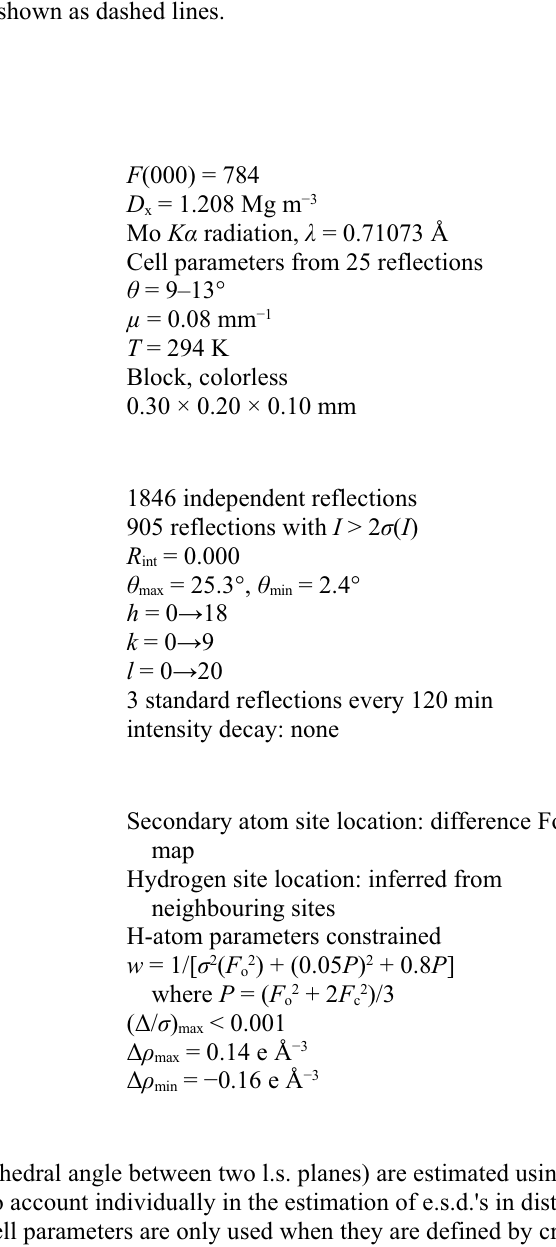
Figure 2 A partial packing diagram. Hydrogen bonds are shown as dashed